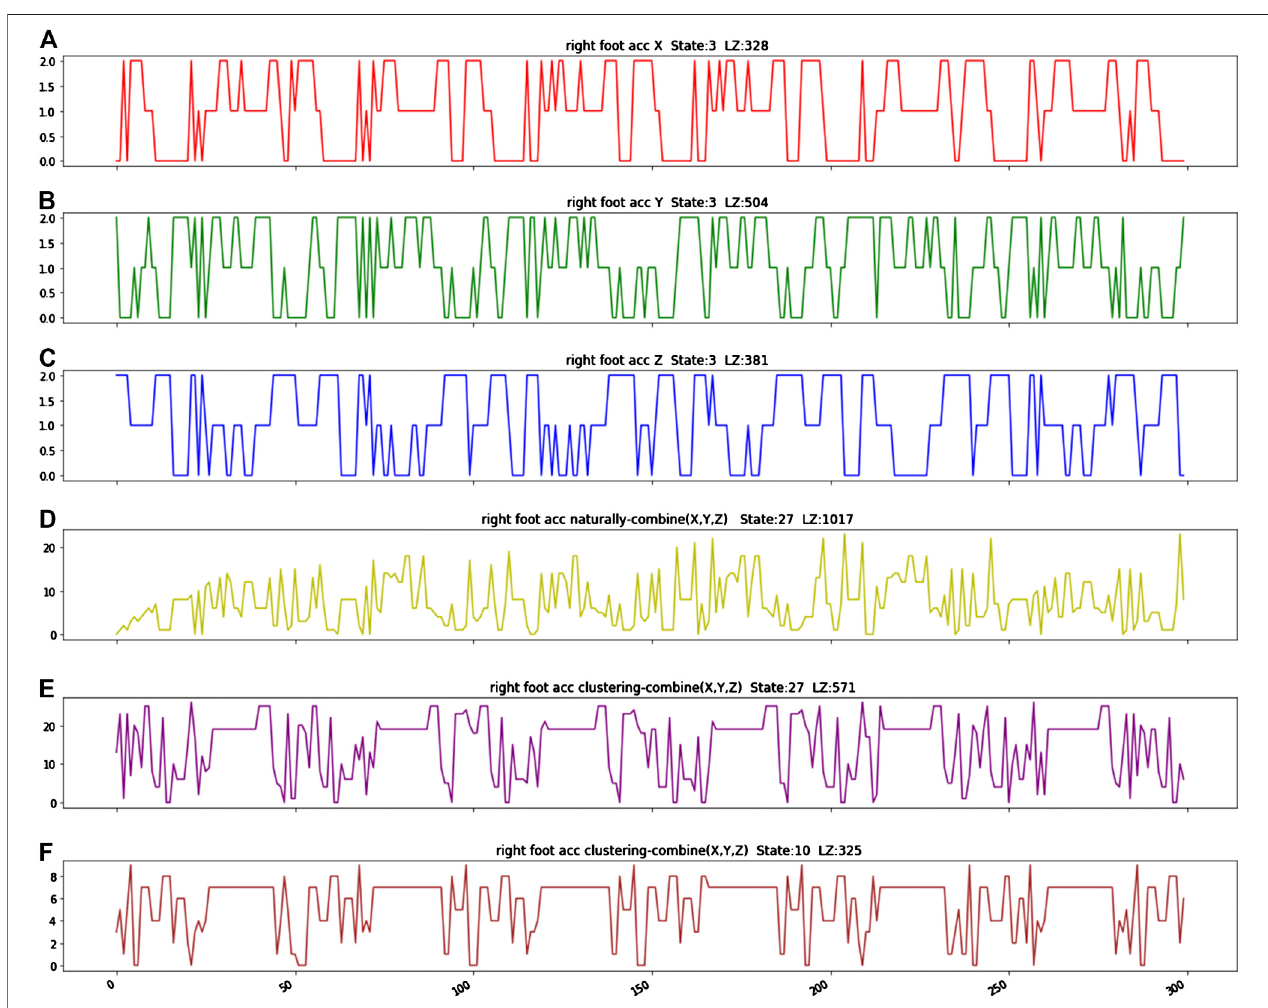
FIGURE 2 | (A – C) Three-state code sequences for X-,Y-,Z-accelerometer time series, respectively. (D) is a natural combination of X,Y,Z, and the resultant sequence is coded by 27 (3 × 3 × 3) states. (E,F) are sequences based on our clustering-based way of combination. (E) is coded by 27 states (clusters), the same number of states as (D) , whereas its LZ complexity reduces by half. (F) is a 10-states code sequence that can show the rhythmic pattern clear enough, and its LZ complexity is as low as that of one-dim time series case.